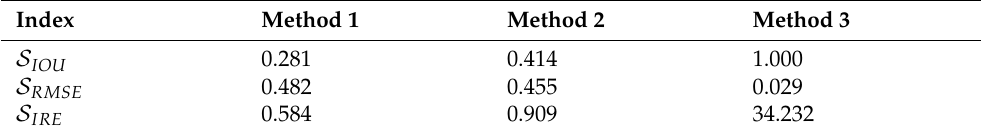
Table 5. Evaluation indexes of inversion results.